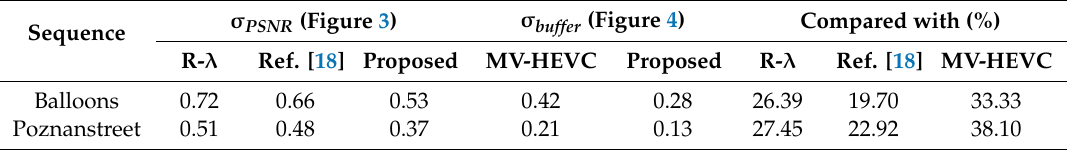
Table 2. Mathematical quantity analysis of the Figures 3 and